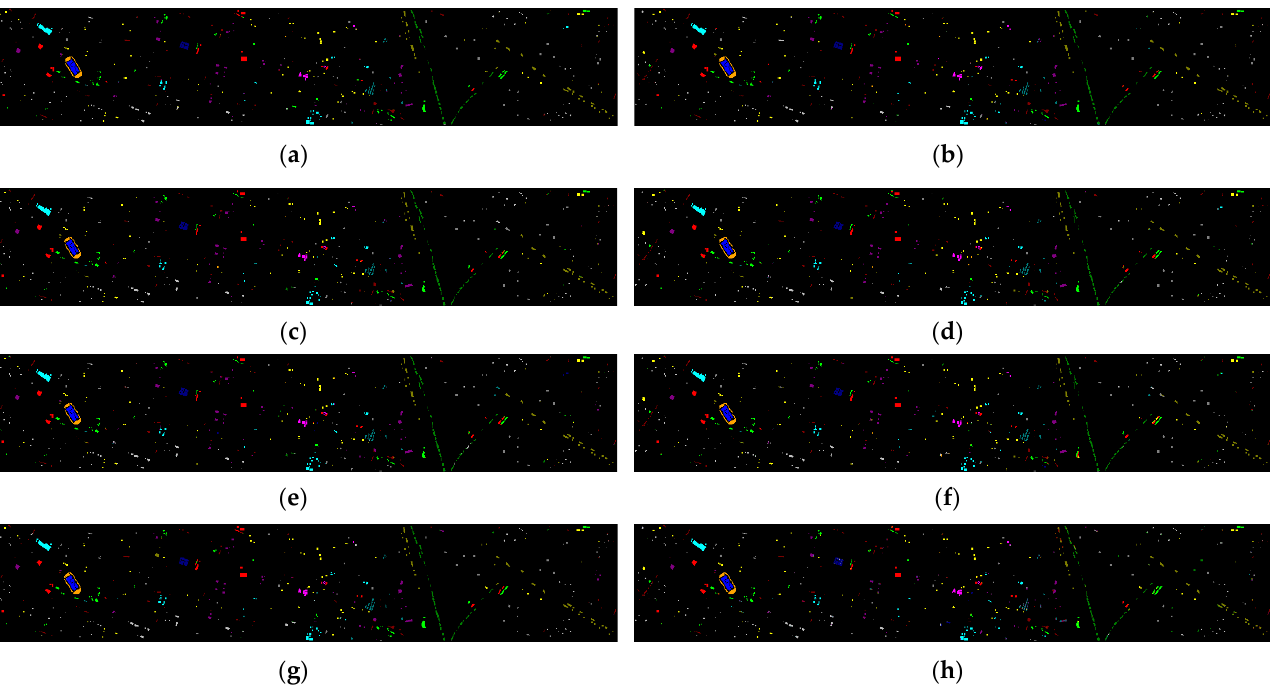
Figure 29. Classification maps using different methods on the Chikusei dataset: ( a ) SCL – MSR; ( b )